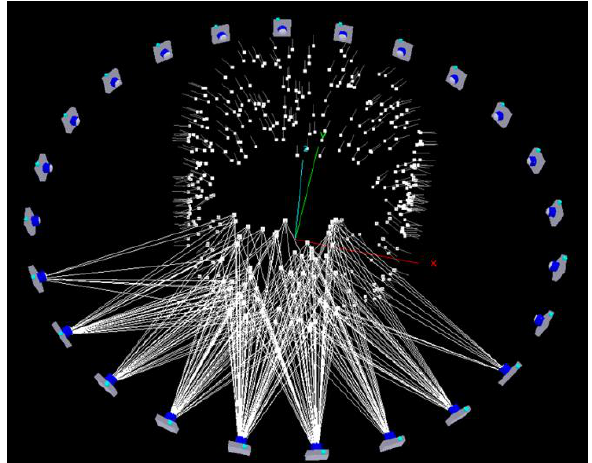
Table 1. Precision (in mm) for the sequence of normal images with a different number of images and 3D points.